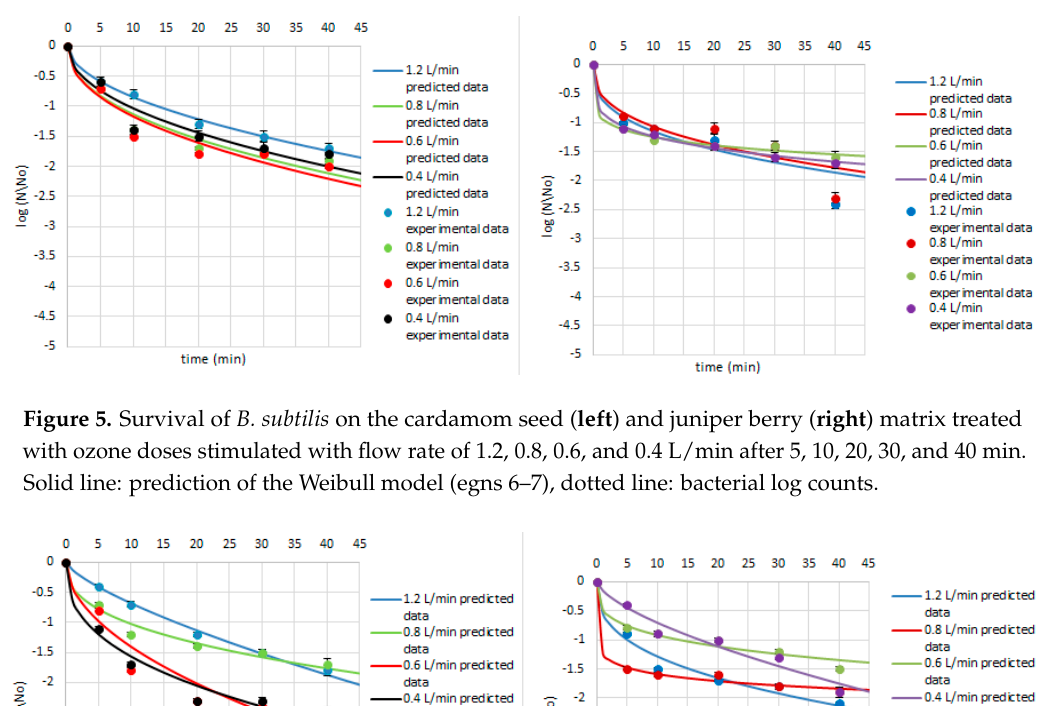
Figure 4. Survival of B. cereus on the cardamom seed ( left ) and juniper berry ( right ) matrix treated with ozone doses stimulated with flow rate of 1.2, 0.8, 0.6 and 0.4 L/min after 5, 10, 20, 30, and 40 min. Solid line: prediction of the Weibull model (egns 4–5), dotted line: bacterial log counts.